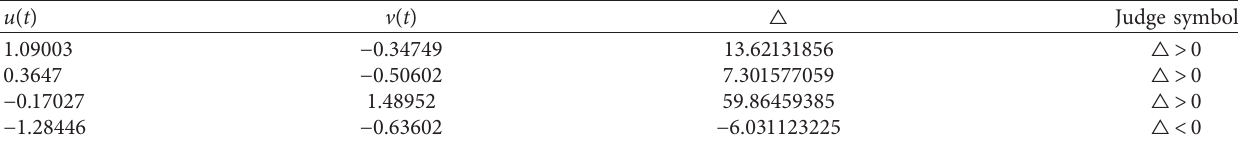
Table 9: Predictive analysis result